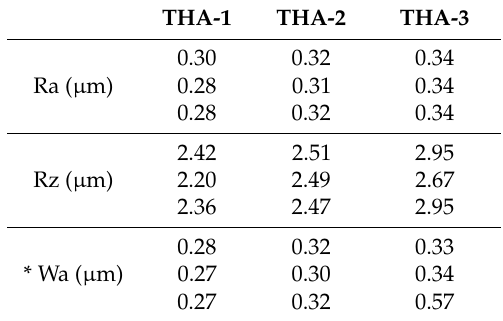
Table 2. The results of surface roughness prior to the merger.